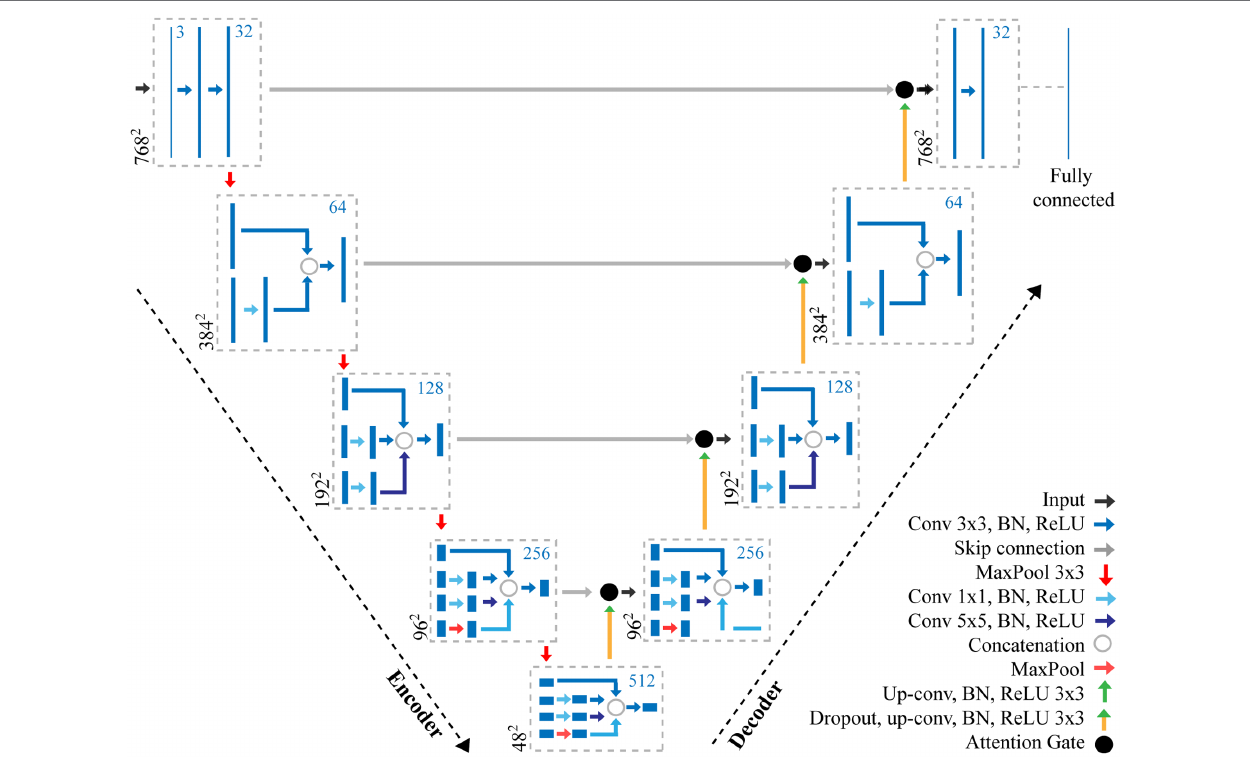
FIGURE 2 | Overview of the adapted CNN used for the extraction of stomata morphometry. The proposed CNN combines features of both an Attention U-Net (Oktay et al., 2018) and Inception (Szegedy et al., 2016) to make pixel-level predictions of stomata for both guard cell and pore. The CNN contains a number of layers including convolution (Conv) layers, Max pooling layers, and fully connected layers. The output of each convolution layer is a set of 2D images, known as feature maps, which are computed by convolving previous feature maps with a filter, the size of which is given in the key. Batch normalisation (BN) and Rectified Linear Units (ReLU) steps are added to normalise data and remove negative pixel values from features maps. Skip connections help to maintain spatial information whilst the Attention Gate removes redundant features. The number of filters at each step is given as the blue number, whilst the resolution is given in